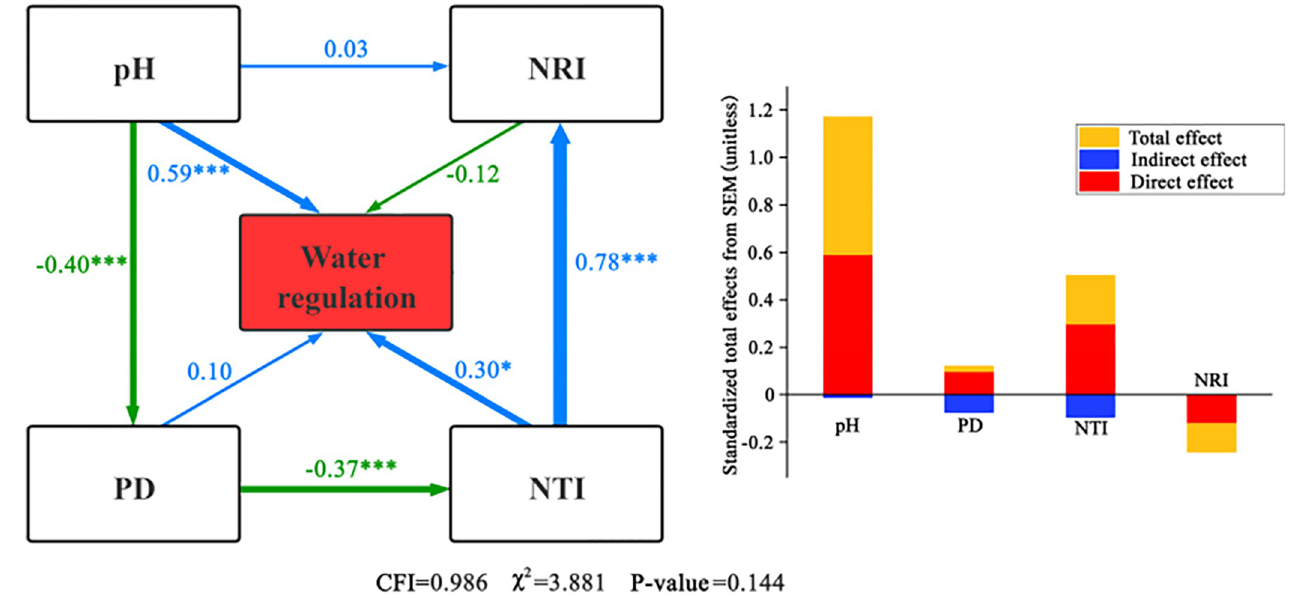
Fig 6. Structural equation model of the relationship between plant diversity, abiotic factors, and water regulation.